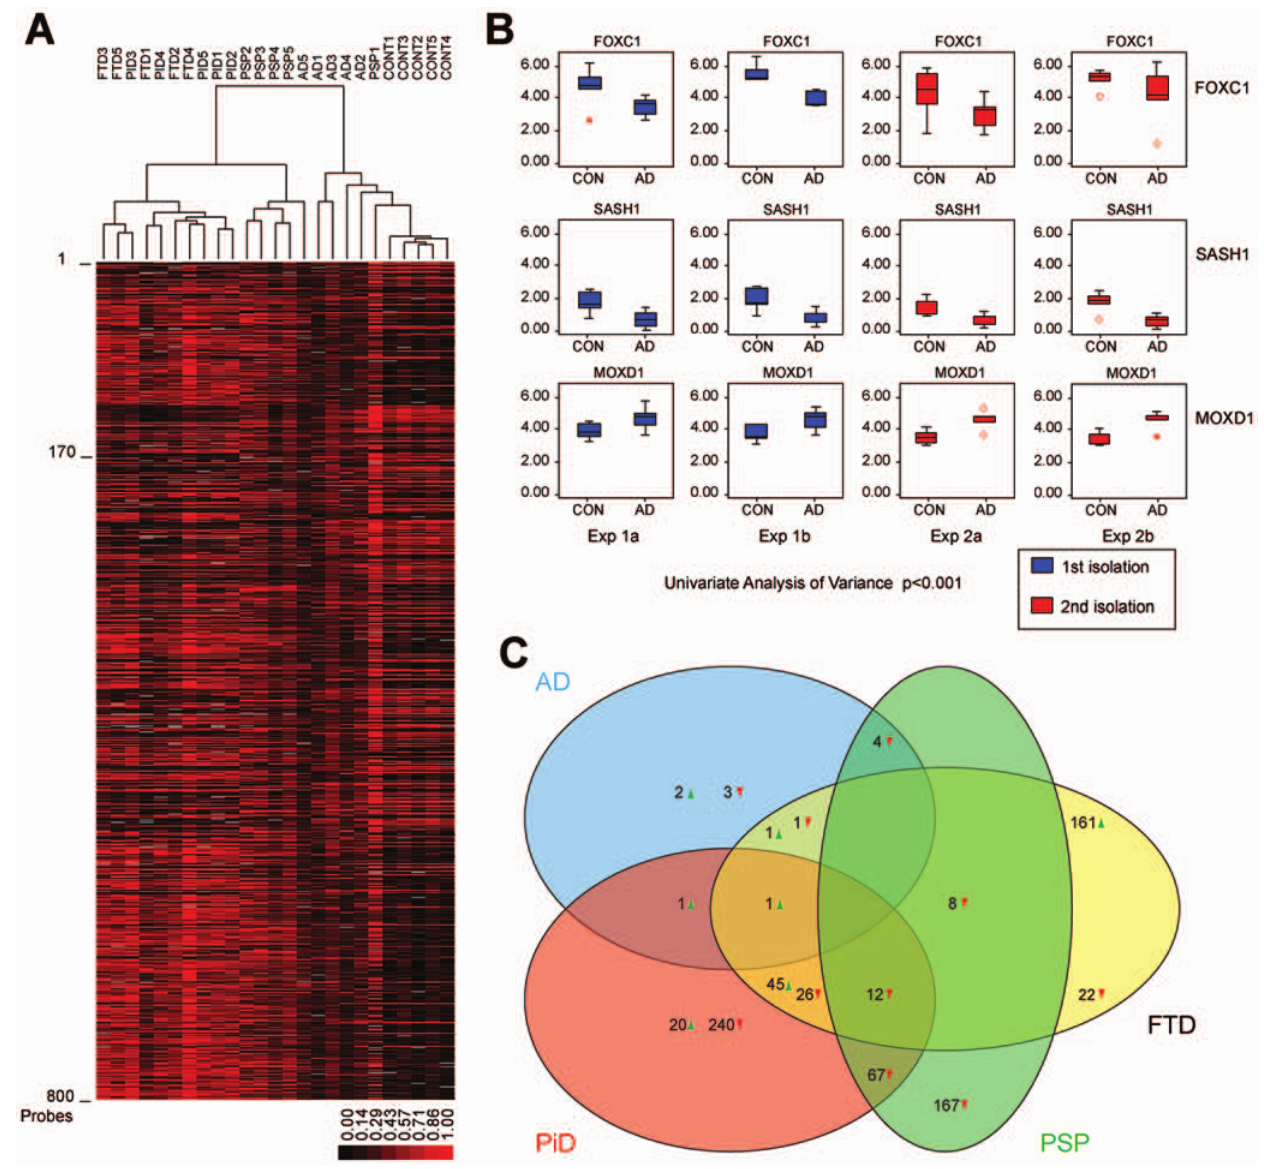
Figure 1. Initial analysis and confirmation of the microarray data. Figure 1A. Clustering of all 25 samples using the background filtered dataset of 790 probes. Figure 1B. Results of quantitative PCR experiments for 3 genes (FOXC1, SASH1 and MOXD1) that were significantly differently expressed in Alzheimer’s disease vs. controls. Experiments were done in duplo (a and b) using cDNA from two separate isolations of the same brain sample (Exp 1 and 2). Statistical testing was done using a Univariate Analysis of Variance with p , 0.001 in all samples. Similar results were observed in the other tested illnesses. Figure 1C. Graphical overview of probes and their correlation between pathology defined groups. Amount of up- and down-regulated probes is shown with up- or downwards facing arrowheads. Pathology defined groups are represented as coloured ellipses; Alzheimer’s disease (AD): blue, Pick’s disease (PiD): red, Frontotemporal dementia (FTD), yellow and Progressive Supranuclear Palsy (PSP): green.